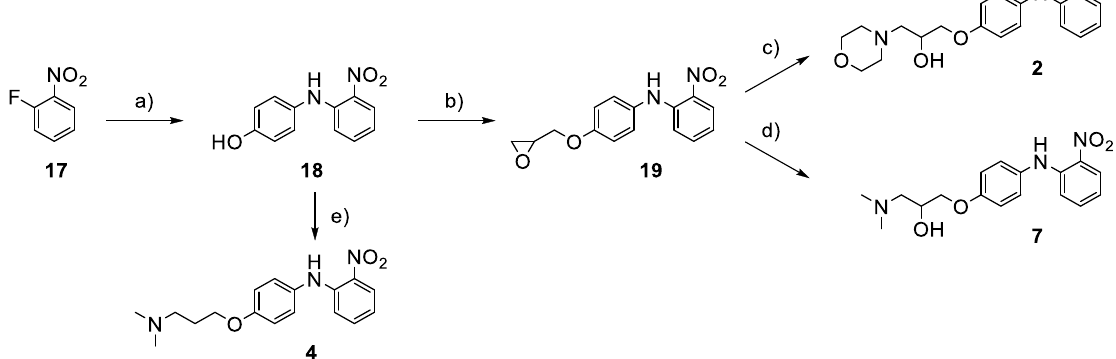
Figure 3. Reagents, solvents and conditions: ( a ) 4-aminophenol, NaHCO 3 , EtOH, 100 °C, 20 h; ( b ) (±)-epichlorohydrin, MeCN, K 2 CO 3 , 80 °C, 16 h; ( c ) morpholine, MeOH, r.t., 36–48 h; ( d ) Me 2 NH × HCl, MeOH, 70 °C, 24 h; ( e ) 3-dimethylamino- 1-propyl chloride hydrochloride, Cs 2 CO 3 , DMF, 100 °C, 3 h.